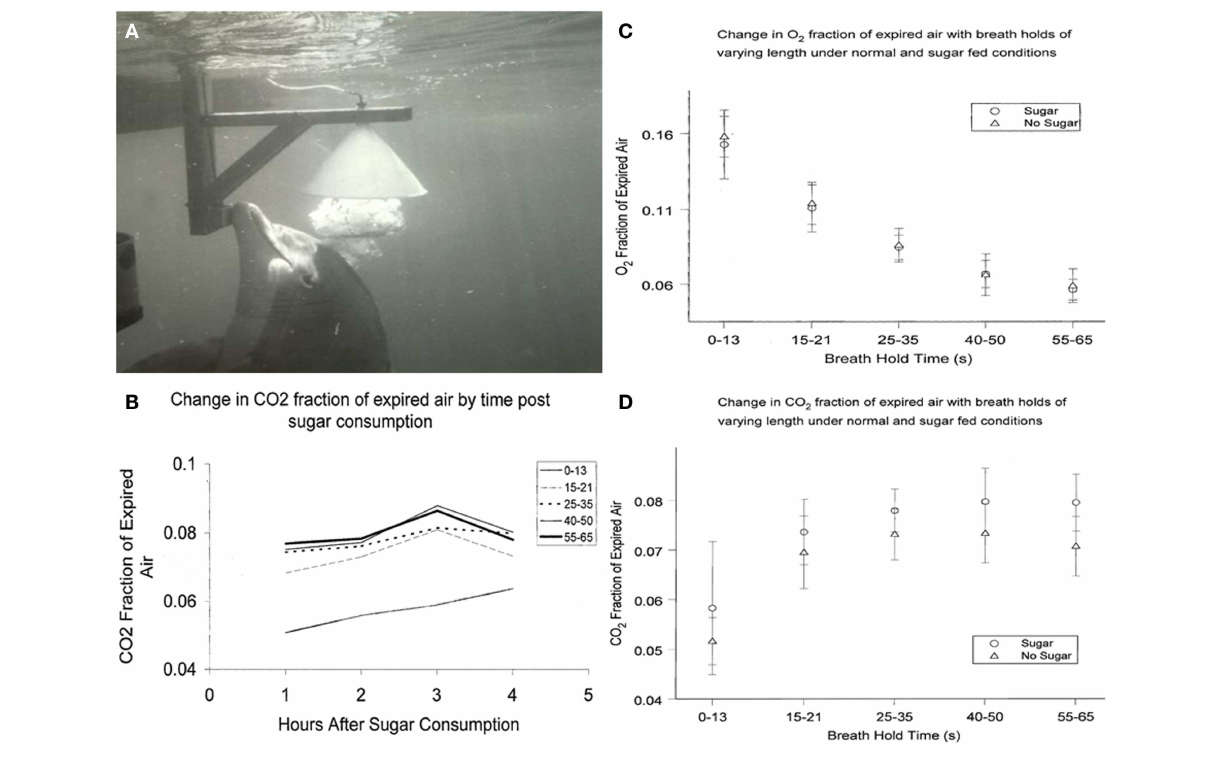
FIGURE 1 | (A) Dolphin exhales, exploding a large bubble into the water-filled collecting funnel. (B) Change in CO 2 fraction of exhaled breath from 1 to 4h after sugar consumption. Breath holds less that about 15s are not as reliable